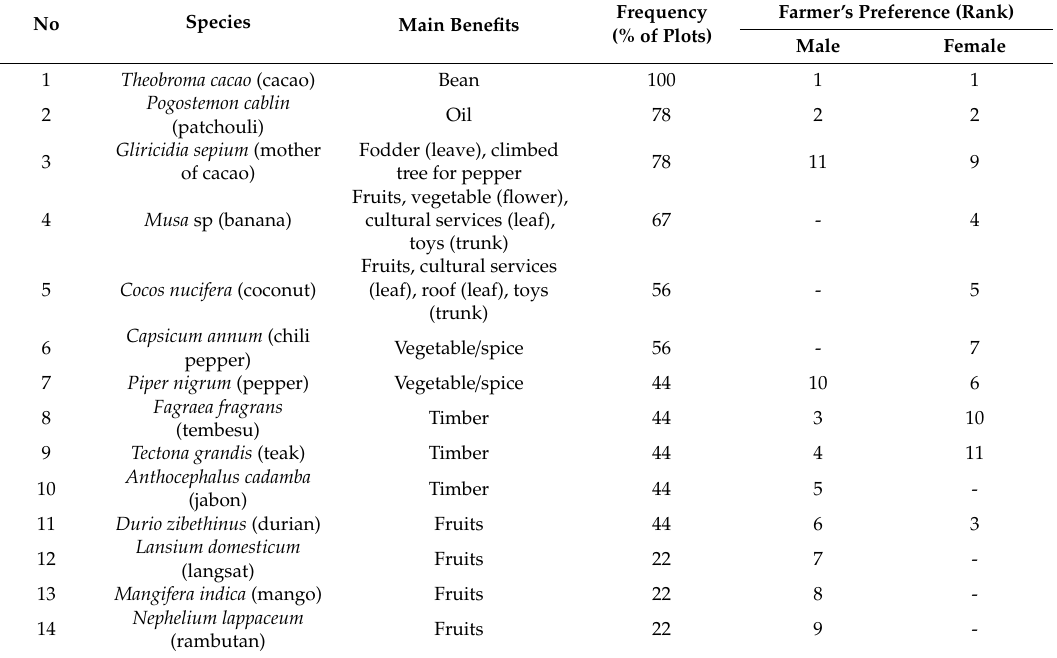
Table 4. Top-ranked plant species in cacao agroforestry systems that are preferred by male and female farmers in the Konawe District, Southeast